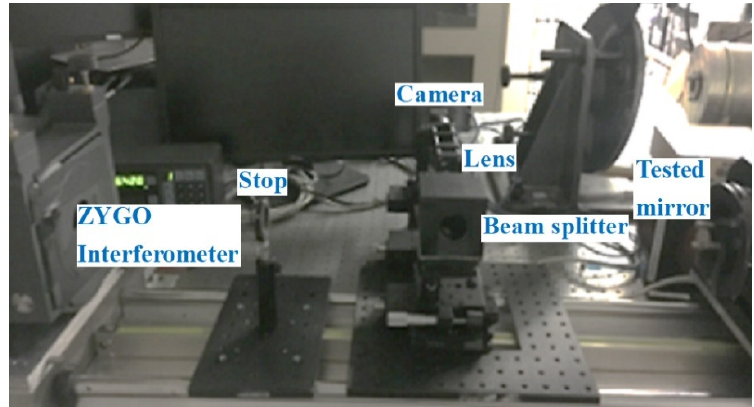
Figure 8. The measurement experiment with the ZYGO interferometer.